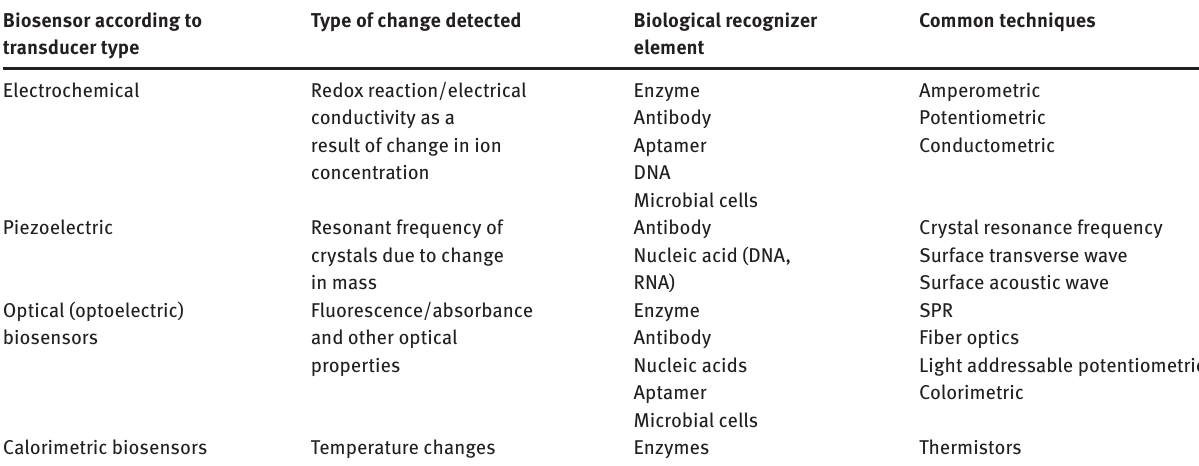
Table 1: Biosensor types, relevant transduction pathway, common techniques employed for each transduction pathways, and prevalent biorecognizing agents for each